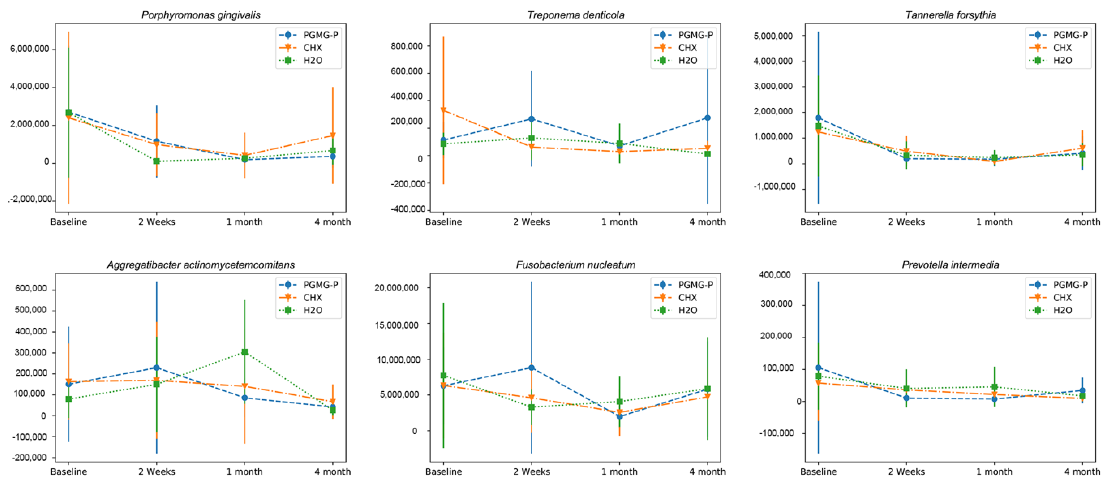
Figure 3. Dynamics of periopathogenic bacteria in the course of the study.